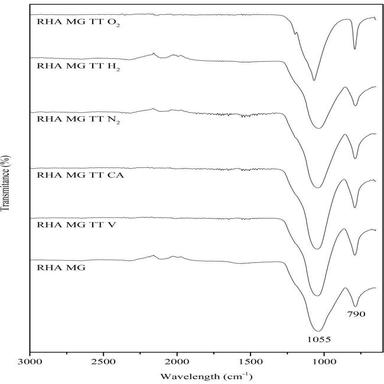
FTIR spectrum of the different heat treatments performed for RHA FB. Fig. 5. FTIR spectrum of the different heat treatments performed for RHA MG.